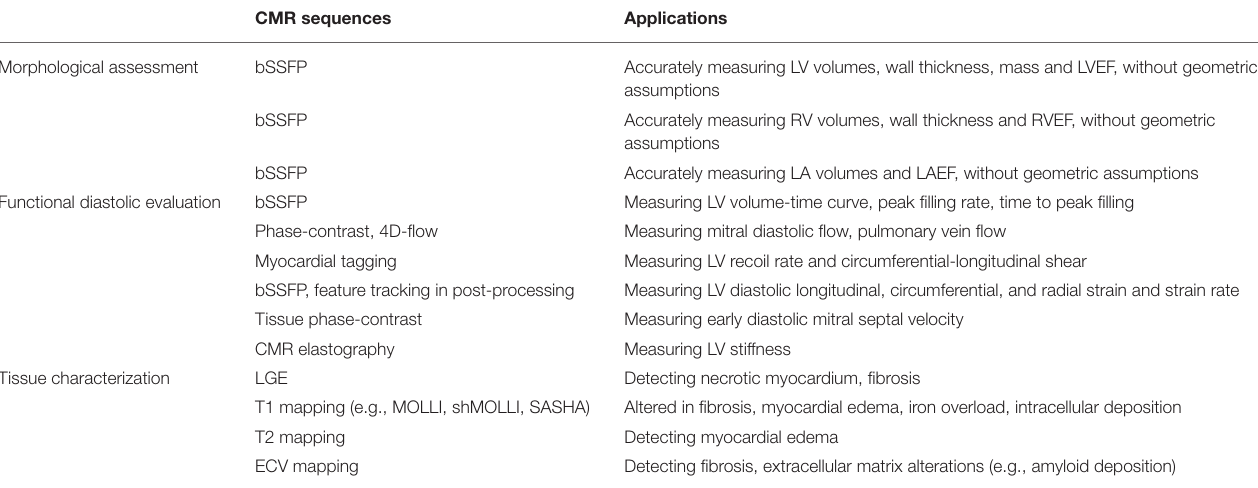
TABLE 3 | CMR sequences and their utility in the assessment of cardiac chambers anatomy, left ventricular diastole, and myocardial tissue in patients with